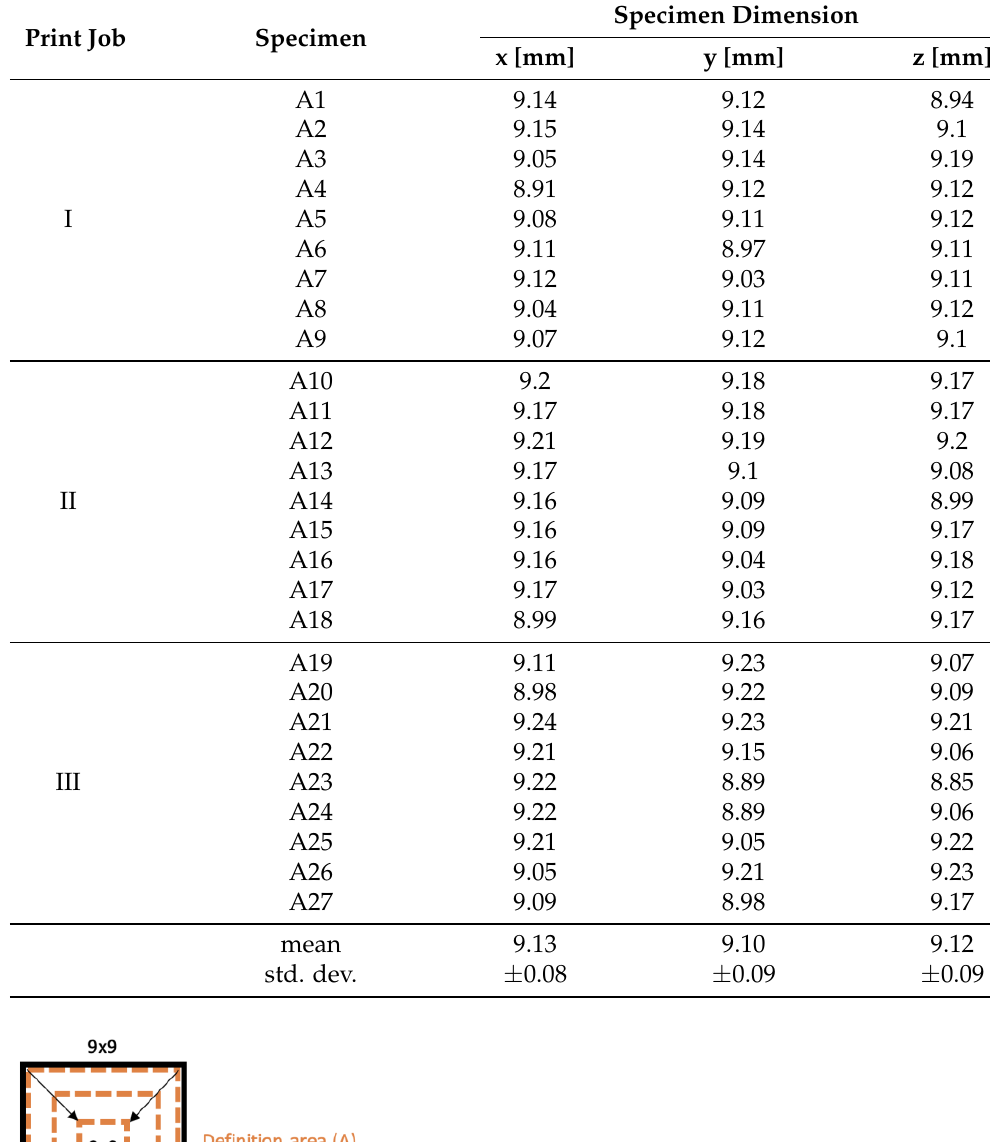
Table 4. Dimensional control of SLM-manufactured specimens.